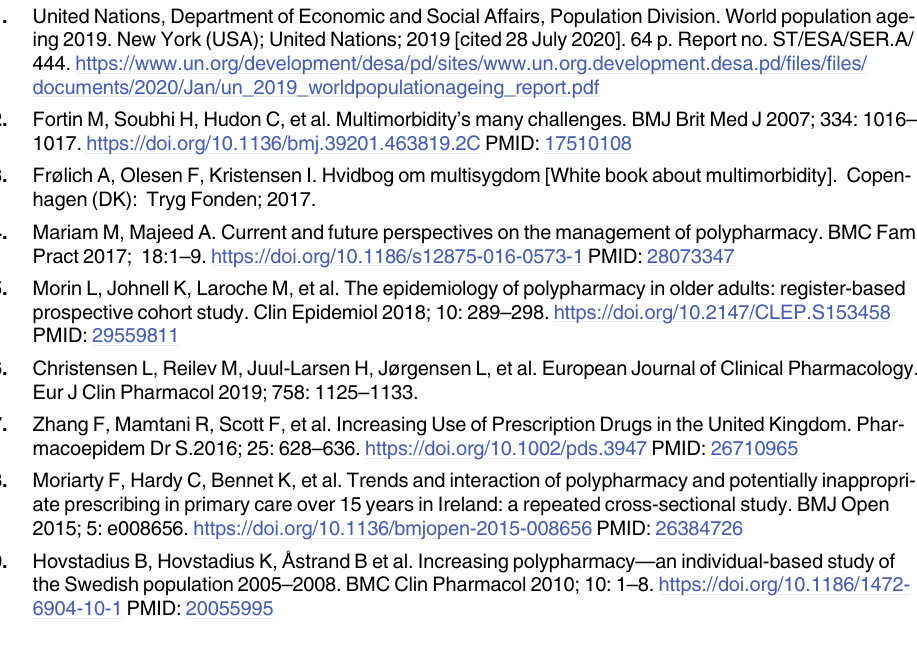
S6 Table. Mean medication use and proportion of polypharmacy cases in the main analysis and sensitivity